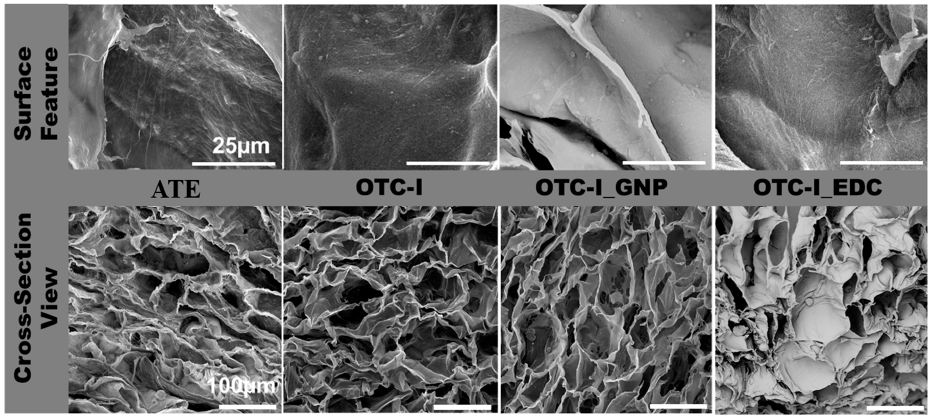
Figure 2. The surface topography and microporous structure of fabricated ovine collagen bioscaffold